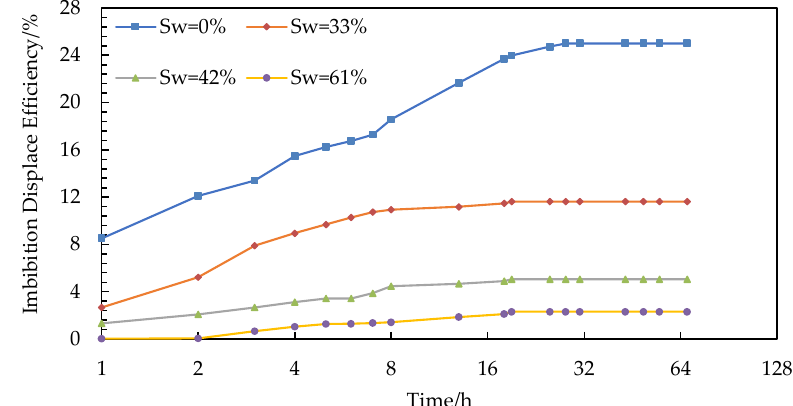
Figure 7. Displacement efficiency curve of imbibition for investigating the initial oil saturation.